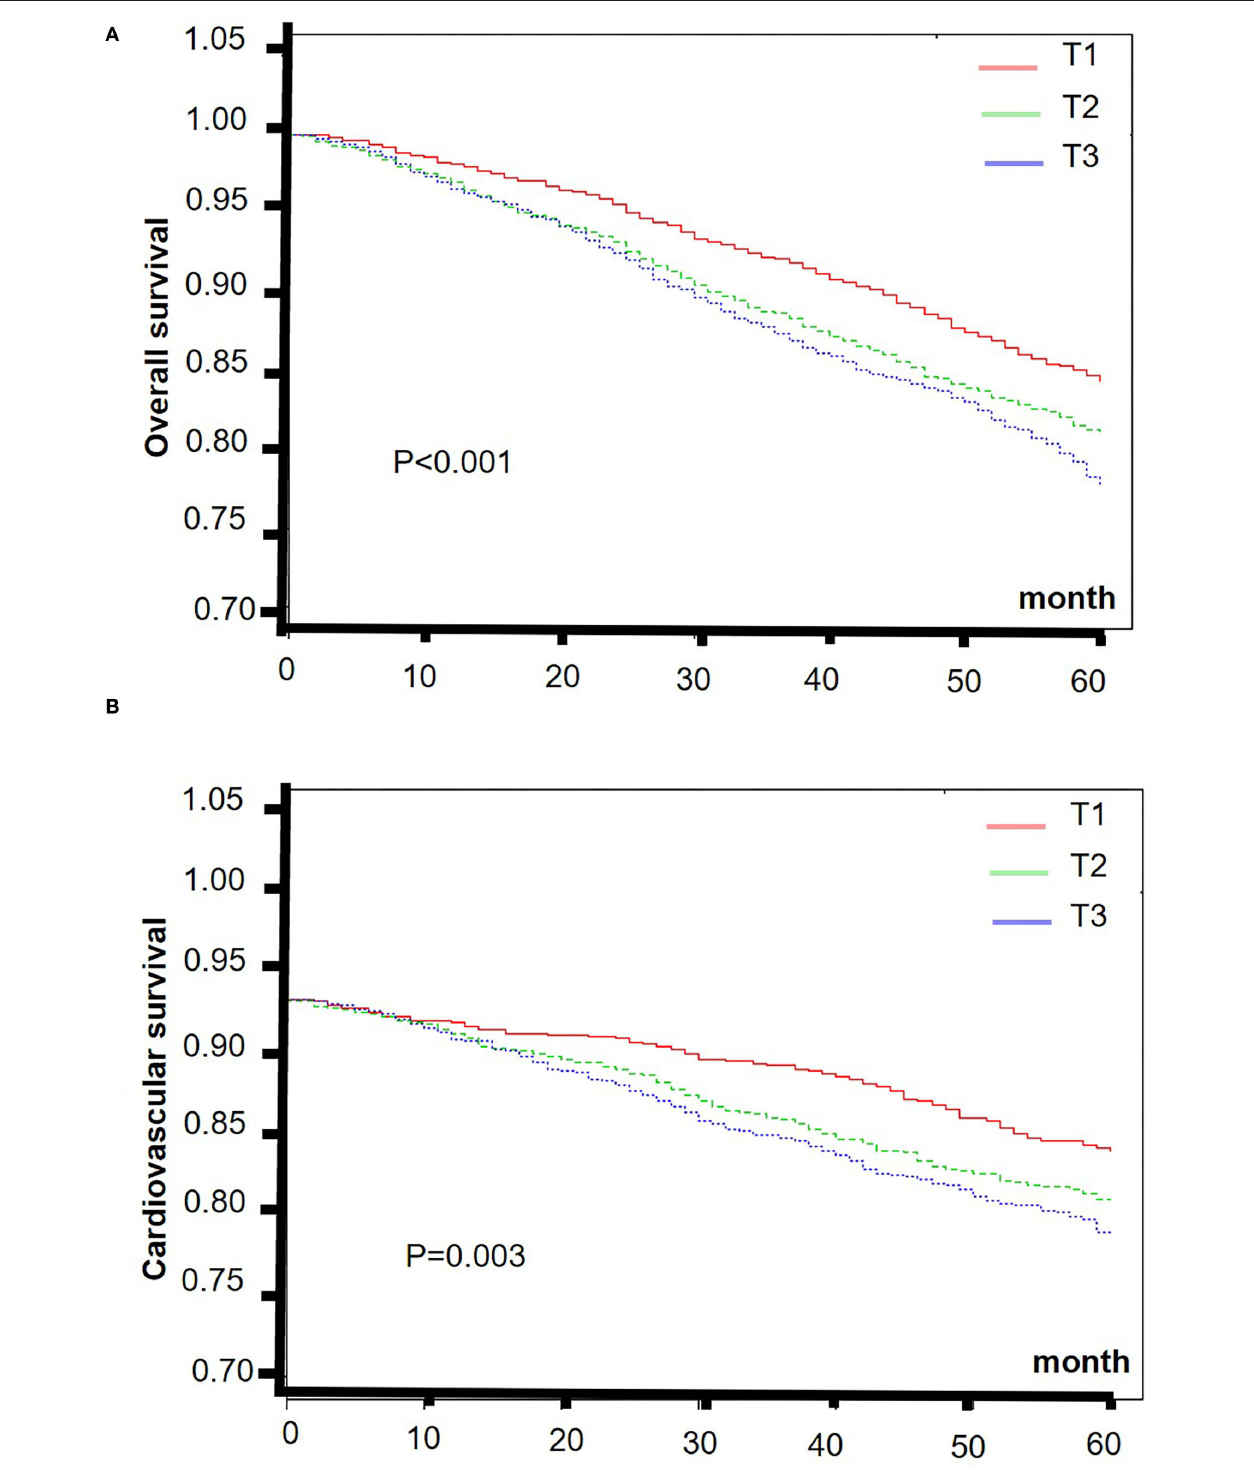
FIGURE 3 | The Kaplan–Meier curves of 5-year overall (A) and cardiovascular (B) survival rates of the lowest and highest tertiles of E-DII among CKD patients. E-DII, Energy adjusted dietary inflammatory index; CKD, chronic kidney disease.